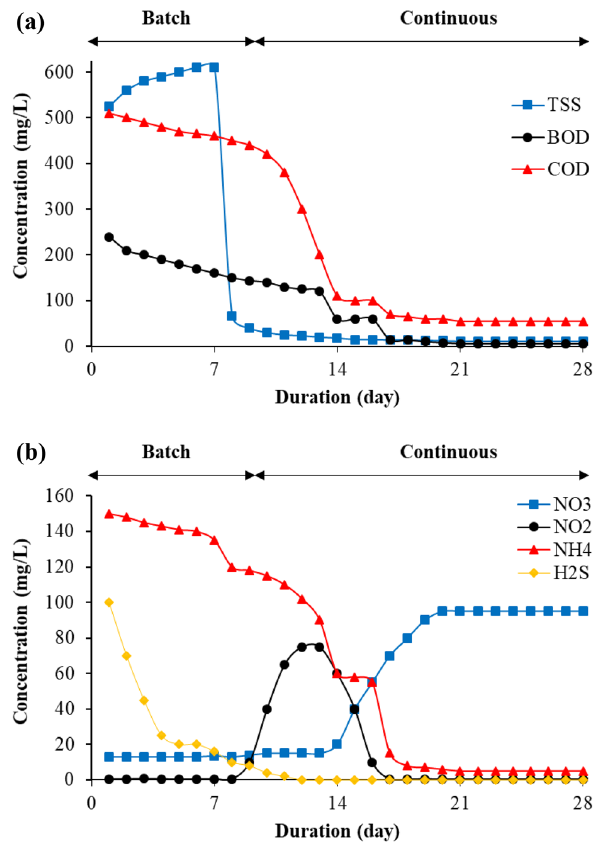
Figure 5. Dynamic state (start-up) of ( a ) organic substrate and ( b ) nutrients fate.